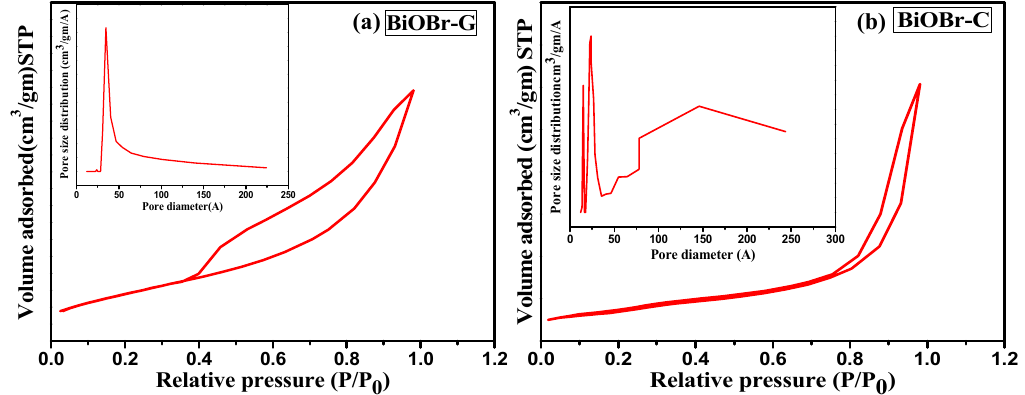
Figure 4. Nitrogen adsorption–desorption isotherms and pore size distribution for ( a ) BiOBr ‐ C and ( b ) BiOBr ‐ G.